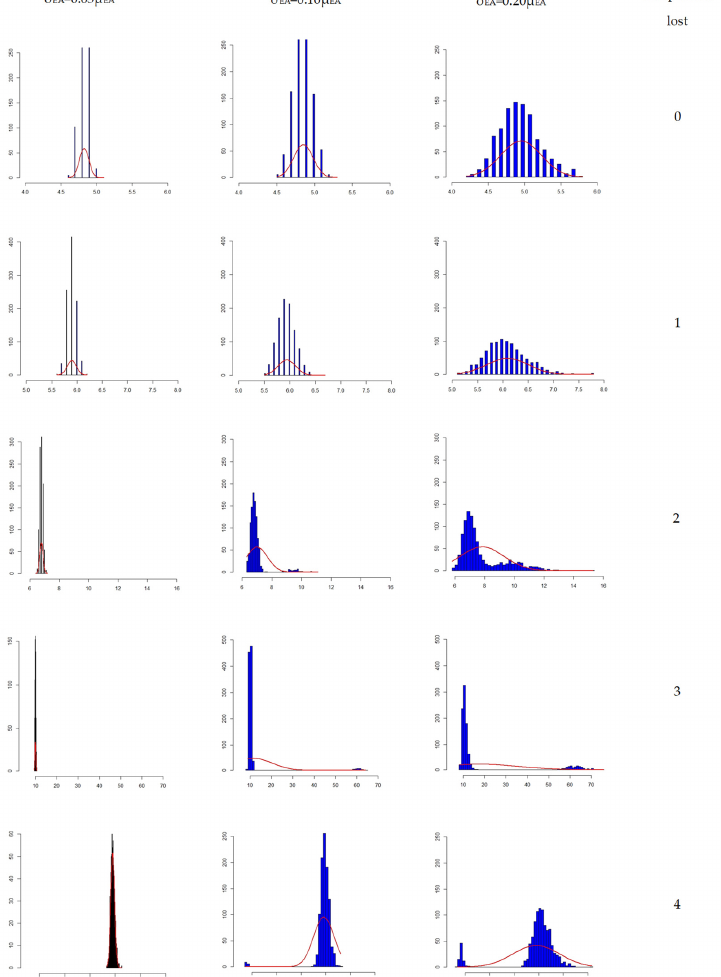
Commented [M18]: 这里作者更改图片把图里的 a,b,c 删 掉了，您看能不能把图名里的 a,b,c 删掉。